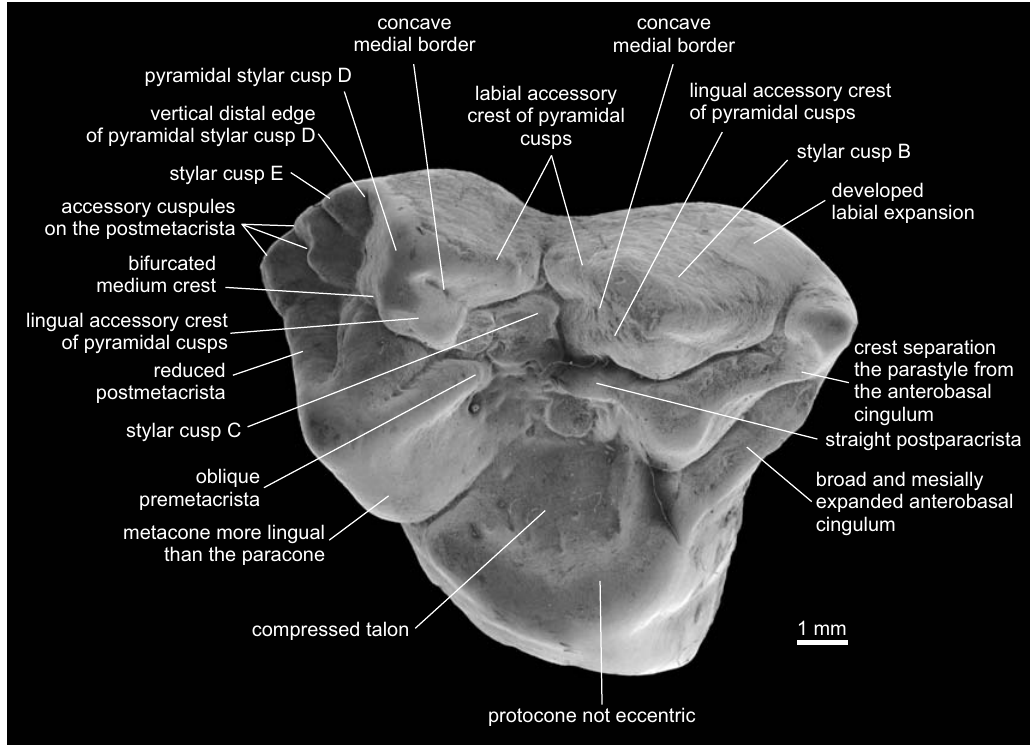
Fig. 1. Type specimen of hatcheriform Zeusdelphys complicatus Marshall, 1987 (MCT 2830-M) from Itaboraí Formation, Brasil; early Eocene (Wood- burne et al. 2014); M1 in occlusal view showing the autapomorphies of this species and Hatcheriformes